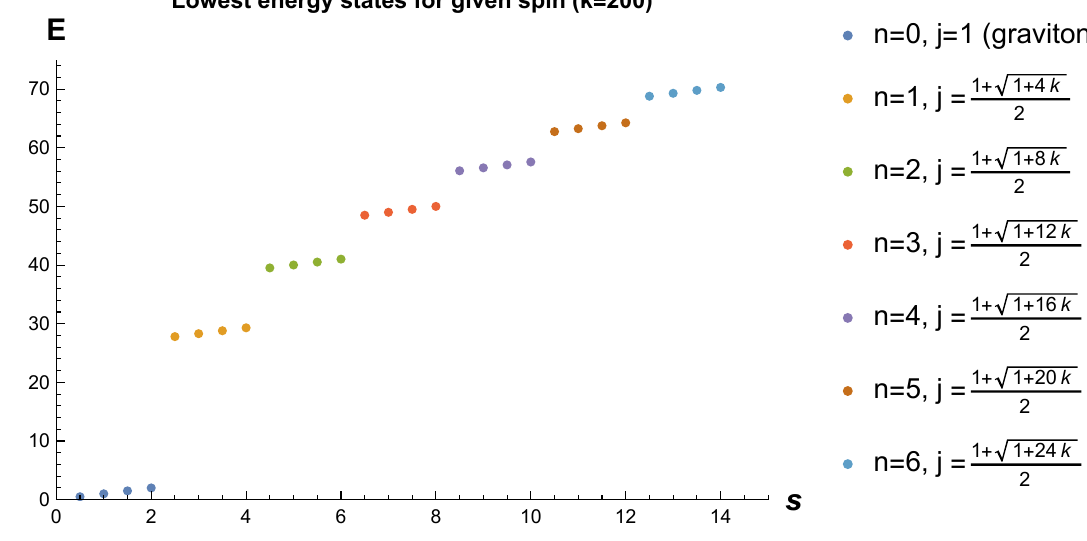
Figure 3 . Dispersion relation of the lowest energy states for k = 200 . The dots correspond to the set of four states singled out in (cid:12)gure 2, depicted here for di(cid:11)erent values of n (i.e. di(cid:11)erent j ), giving rise to di(cid:11)erent ranges 2 n + 1 = 2 (cid:20) s (cid:20) 2 n + 2 of the spin. In each family of four dots, the last one describes a unique state, the corner state of (cid:12)gure 2, while the (cid:12)rst three correspond to states with higher